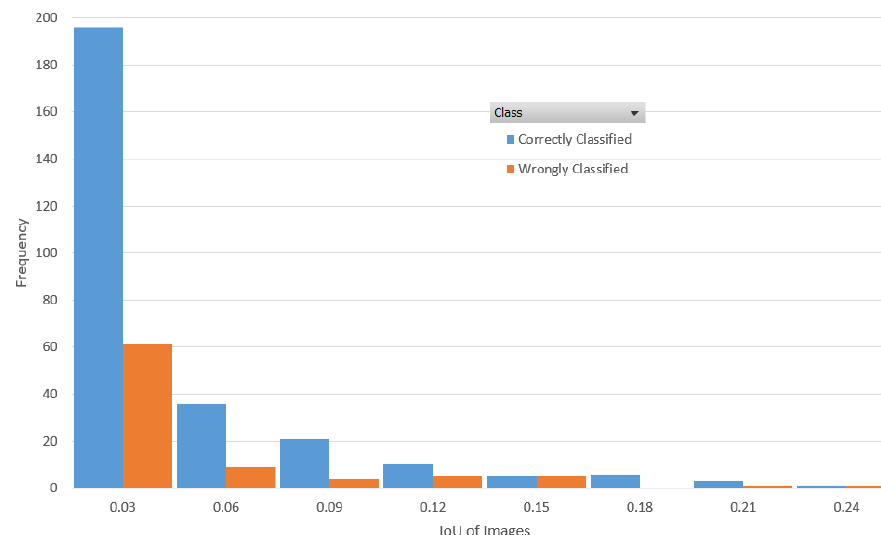
Figure 9. Histogram of IoU of network and lesion mask.